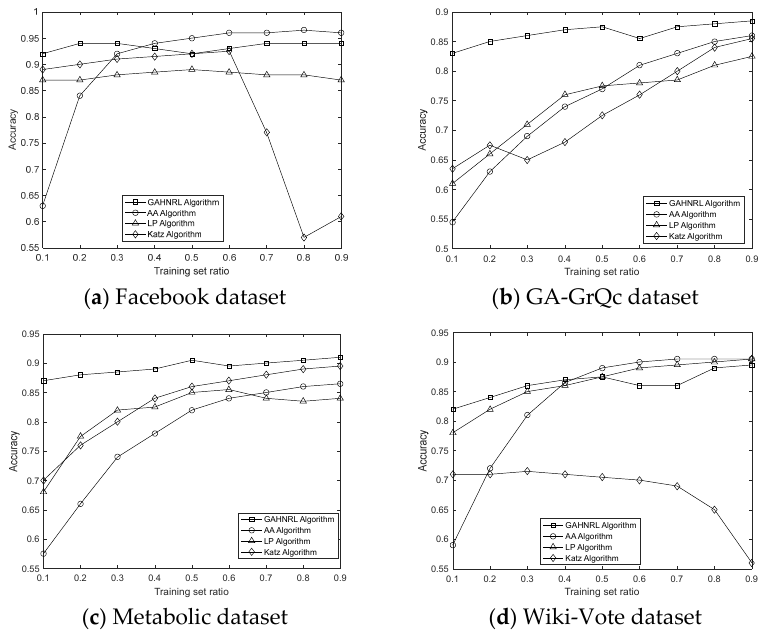
GAHNRL Algorithm AA Algorithm LP Algorithm Katz Algorithm